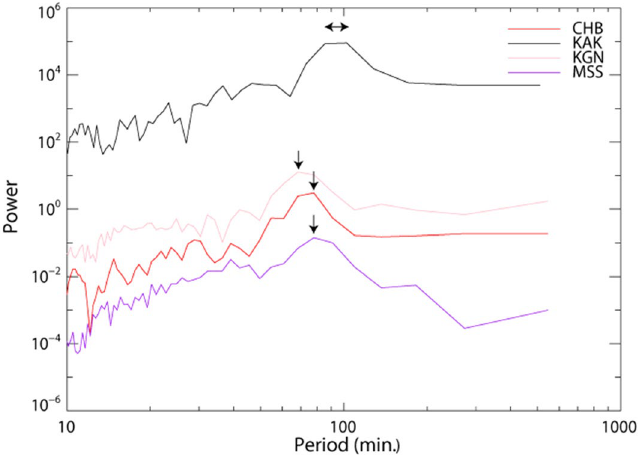
Figure 3. A periodogram of the oscillations of the atmospheric electric fields at the four sites during snowfall. The arrows indicate the maxima of the power spectra for each